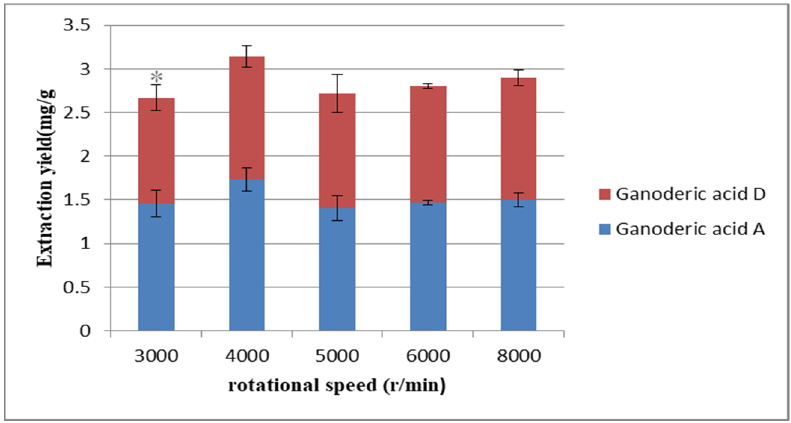
Figure 7. Effect of rotational speed on the extraction yield. Compared with 4000 r/min group: * p < 0.05.